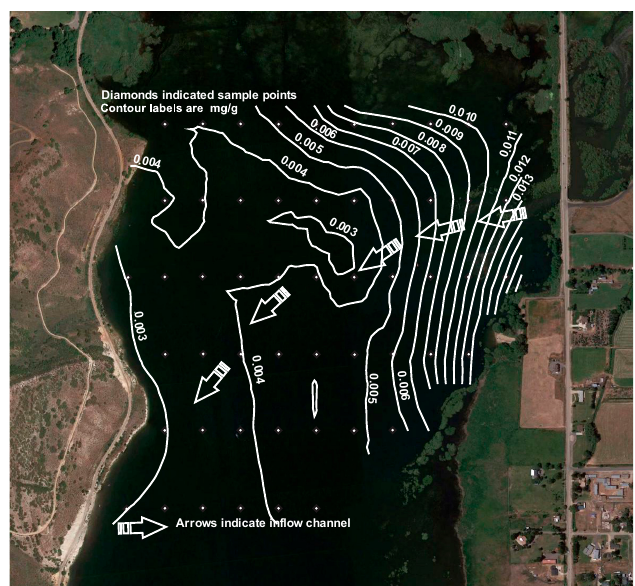
Figure 3. Contours of the Fr.W (water ‐ soluble) fraction from the surface samples. Arrows indicate the inflow talweg, which is better seen in the left panel of Figure 1. The general spatial distribution follows the inflow channels.